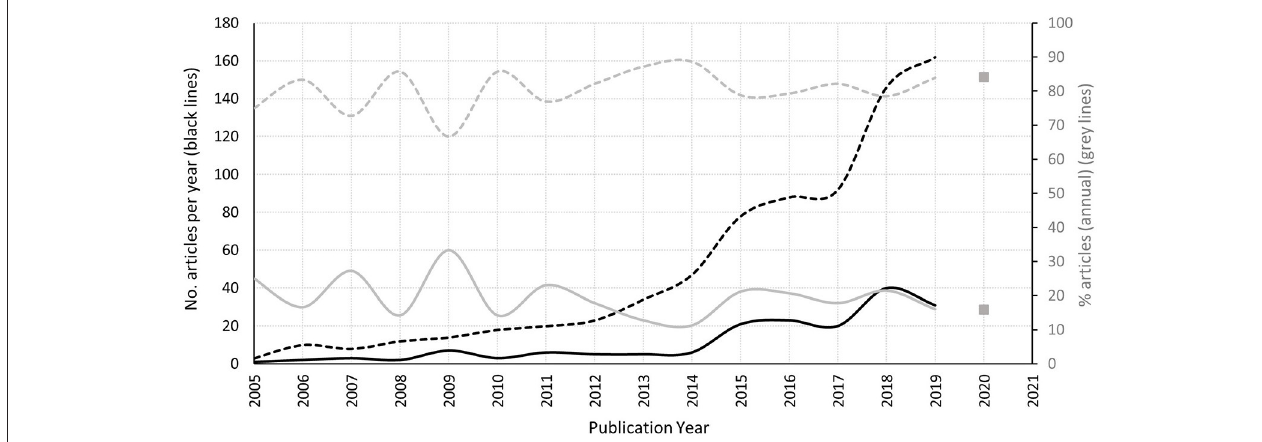
FIGURE 1 | Publications about USV applications (solid) and developments (guidance, control, design, navigation and engineering) (dashed) raw counts (black) and proportion of annual total (grey) vs. publication year based on publications between January 2005 and August